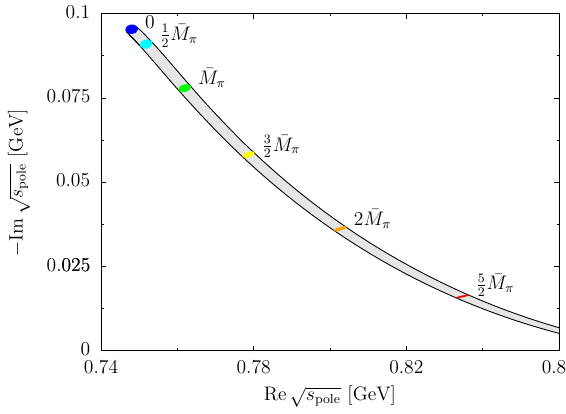
Fig. 1 Trajectory of the ρ pole position of t II in the complex s plane as given in Eq. (7) for different pion masses. The gray error band is generated by the uncertainty of F and ¯ l . The colored ellipses mark the one- σ uncertainty regions of the pole position for the respective pion